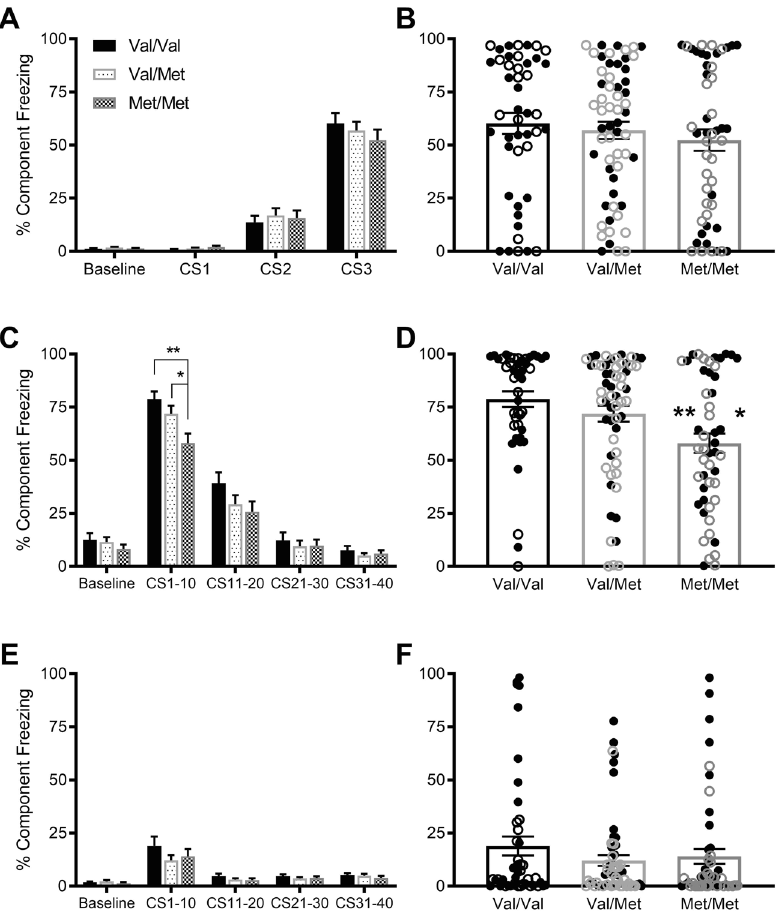
Fig. 1 Fear conditioning in adult rats. Fear learning in adult rats across three CS tone periods on Day 1 ( A ) and CS3 only ( B ) shows no difference between genotypes. While there was no difference between genotypes in extinction learning as shown by the decrease in freezing across four periods of 10 CS tones on Day 2 ( C ), fear memory was shown to be decreased in Met/Met rats during CS1 – 10 ( D ). There were also no genotype differences in extinction memory on Day 3 when looking at average freezing across four periods of 10 CS tones ( E ) or when comparing freezing for CS1 – 10 only ( F ). Data are presented as mean ± SEM. Individual data points are only shown for ( B ), ( D ), and ( F ) for clarity. There were no signi fi cant interactions with sex therefore all data are presented as sexes combined (males closed symbols, females open symbols). ** p < 0.001 vs. Val/Val, * p < 0.05 vs.